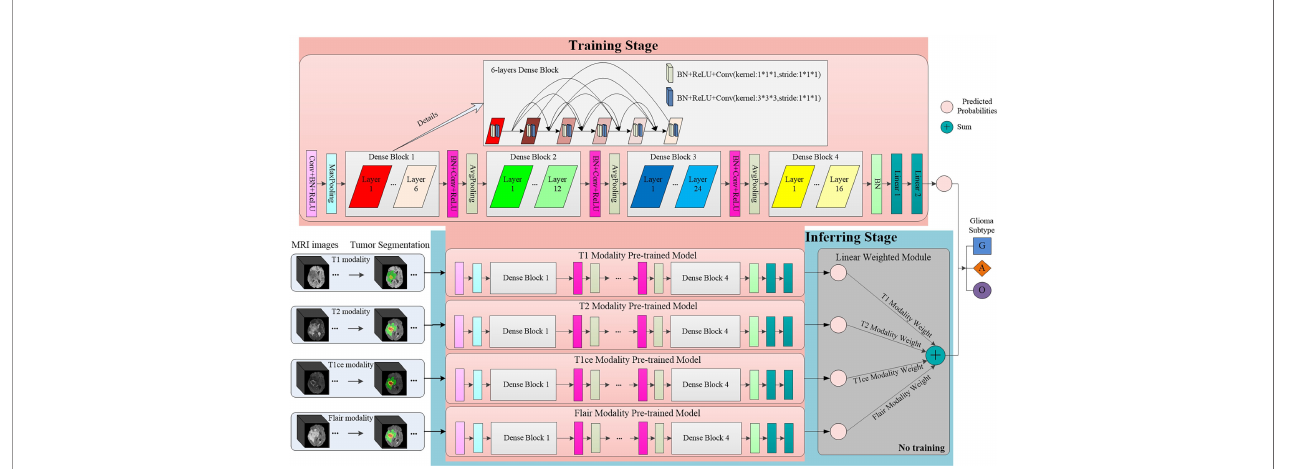
FIGURE 1 | The structure of our proposed MMIDFNet.